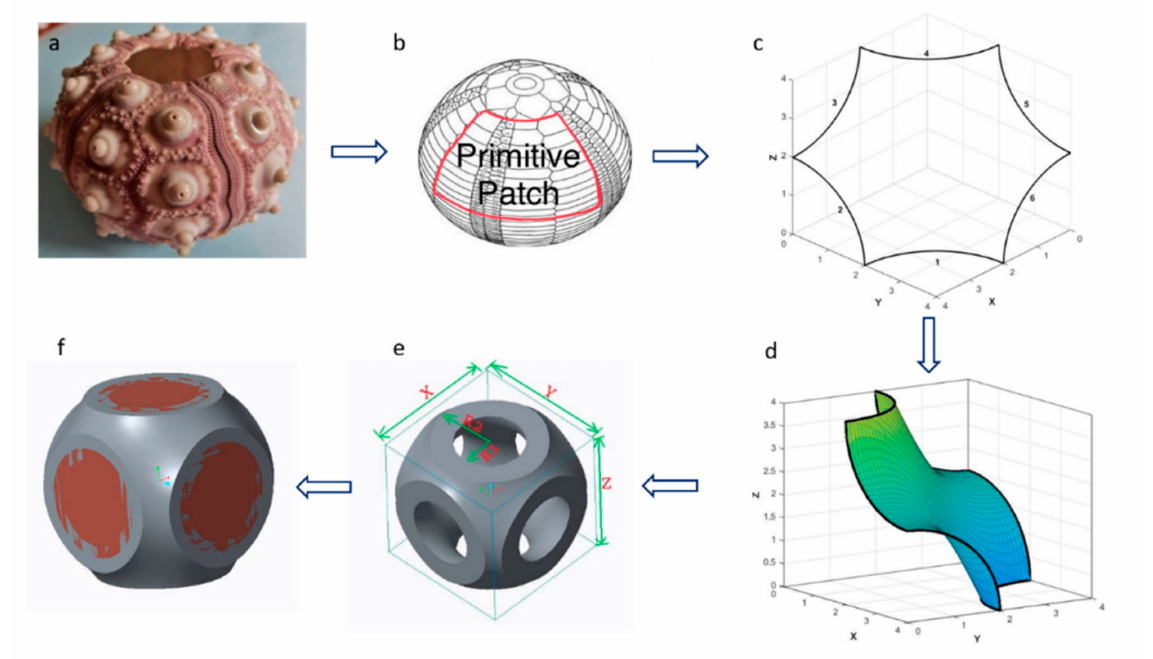
Figure 1. The biomimetic local closed-cell lattice structure based on SU morphology ( a ) SU morphol- ogy ( b ) primitive patch ( c ) primitive patch developed by boundary equation ( d ) surface generation on the boundary equation and mirroring of this surface patch for final design in Creo ( e ) final design of supportless open-cell lattice structure in Creo parametric ( f ) closed-cell designed by closing the openings of the open-cell lattice